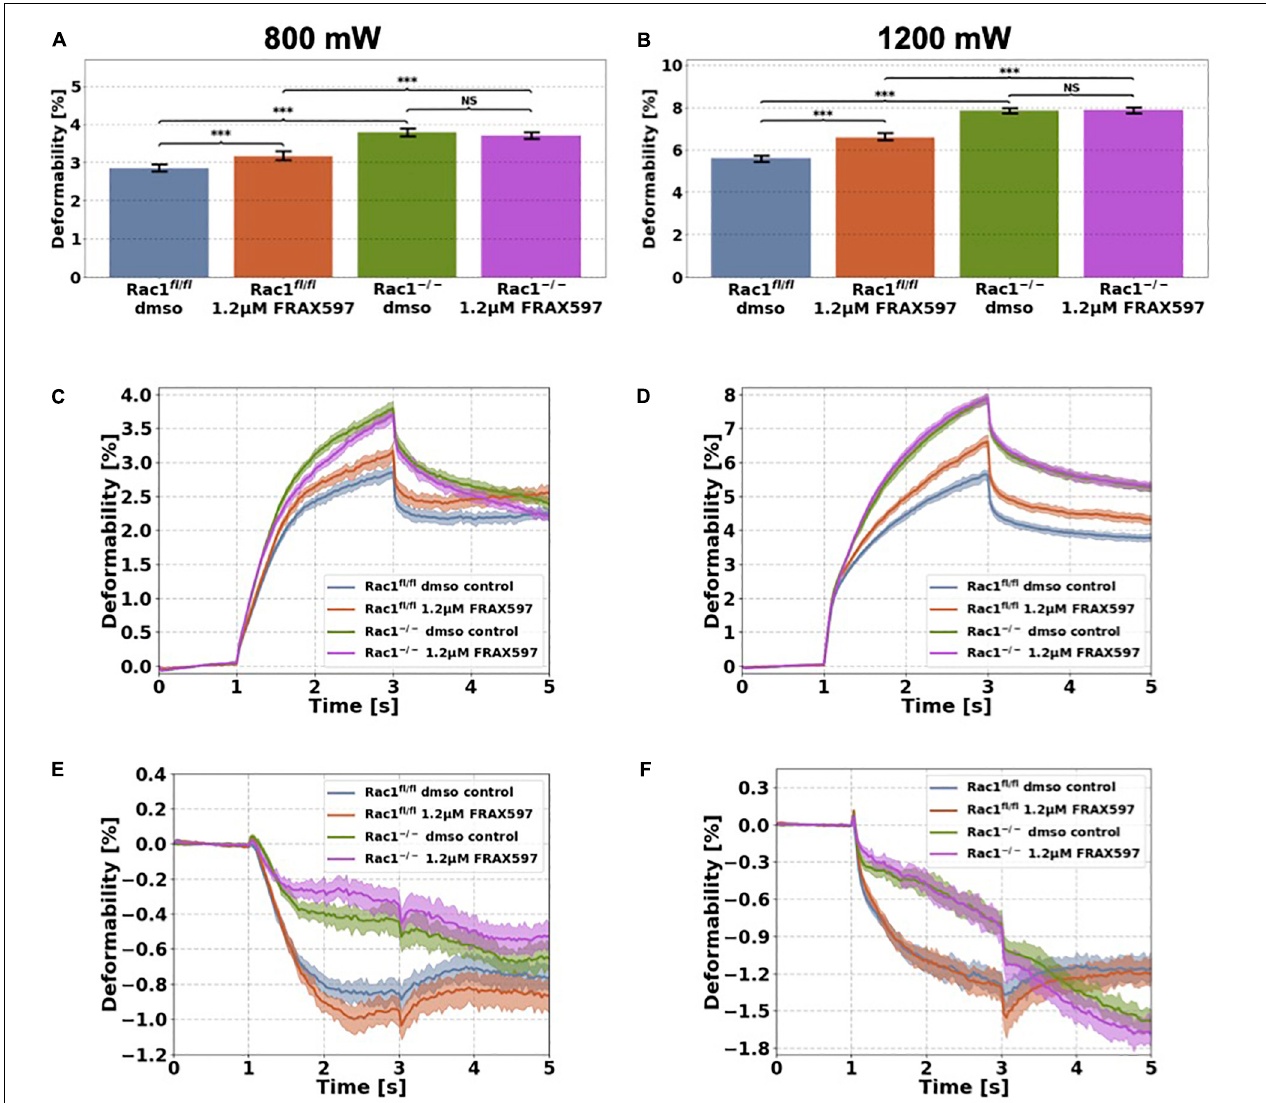
FIGURE 4 | Cellular stiffness (inverse deformability) of non-adhesive Rac1 fl / fl and Rac1 − / − cells stimulated with 1.2 µ M FRAX597 using an optical cell stretcher. Cells are trapped for 1 s at 100 mW laser powers and then stretched for 2 s by increasing laser powers up to 800 mW (A,C,E) or 1200 mW (B,D,F) along laser beam axes. After stretching process, laser powers were reduced to 100 mW and viscoelastic relaxation was observed for 2 s. Maximal deformation of Rac1 fl / fl cells is pronouncedly increased (stiffness decreased) by 1.2 µ M FRAX597 for 800 mW (A) and 1200 mW (B) laser powers. Maximal deformation of Rac1 − / − cells was unaffected by 1.2 µ M FRAX597 for both laser powers. The data are presented as median with SD. Cellular deformation along the long axis (parallel to laser beam axes) of Rac1 fl / fl and Rac1 − / − cells treated with 1.2 µ M FRAX597 for 2 h at laser powers of 800 mW (C) and 1200 mW (D) . Mechanical behavior along the short axis (perpendicular to laser beam axes) of Rac1 fl / fl and Rac1 − / − cells treated for 2 h with 1.2 µ M FRAX597 at laser powers of 800 mW (E) and 1200 mW (F) . Data are presented as median values with confidence interval (2*SD) of 95.46%. A p -value of 0.05 is considered as statistically significant, *** p < 0.001 and NS, not